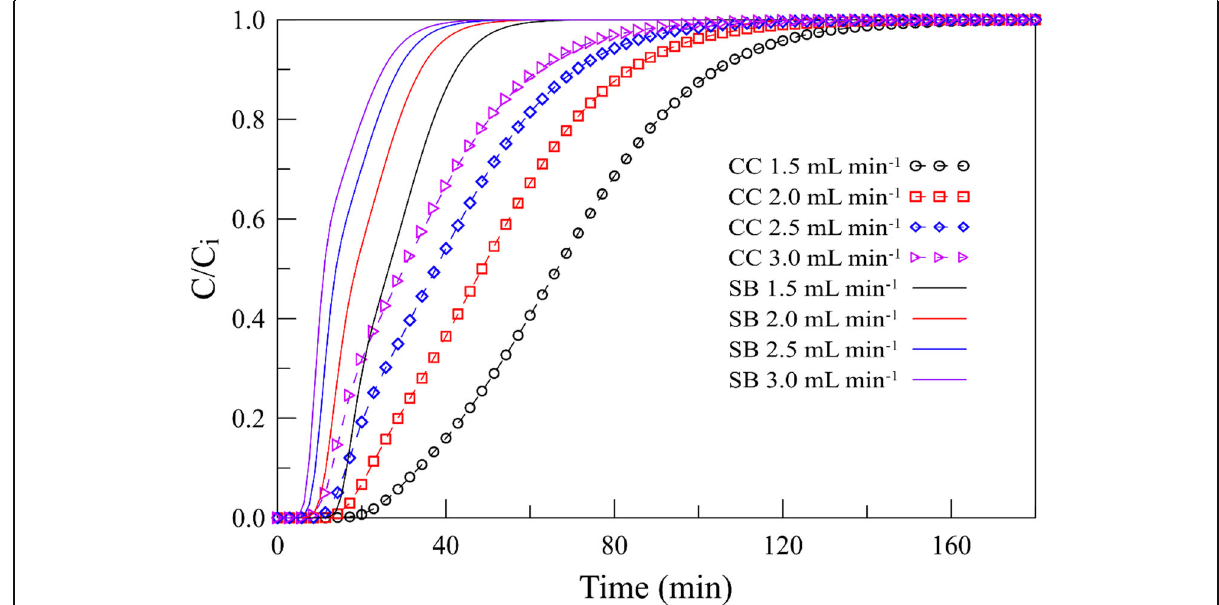
Fig. 3 Breakthrough curves of ACT adsorption on SB and CC by varying the feed flow